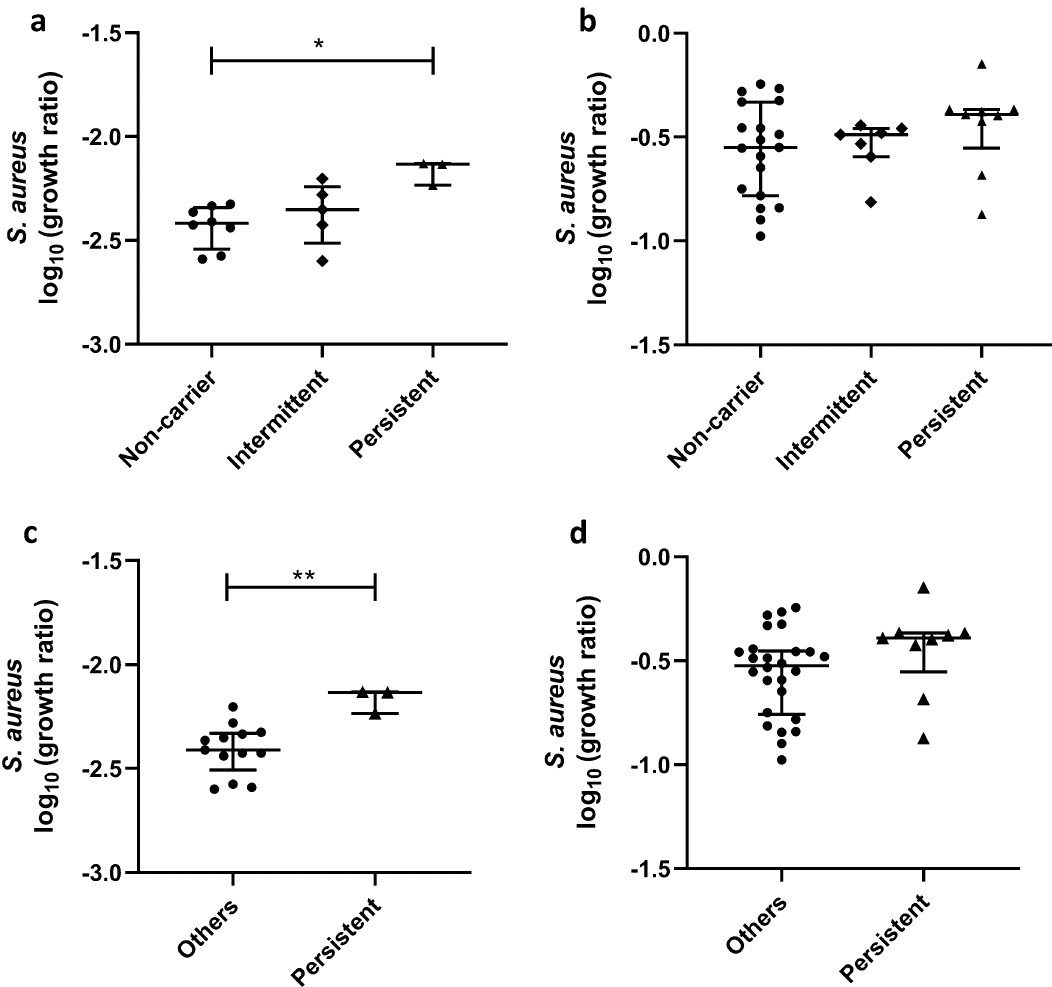
consecutive cultures were positive, ‘intermittent’ carriers if one or more non-consecutive cultures were positive or ‘non-carriers’ if all 3 cultures were negative. Baseline S. aureus GIA results stratified by carriage status are shown for whole blood ( a ) and PBMC ( b ). Stratified using a reclassification of carriage types into two categories (‘persistent’ carriers and ‘others’) proposed by Van Belkum et al. 43 , S. aureus GIA baseline results are shown for whole blood ( c ) and PBMC ( d ). Bars represent the median values with the interquartile range (IQR). A Mann– Whitney test was performed where *indicates a p -value of < 0.05 and **indicates a p -value of <